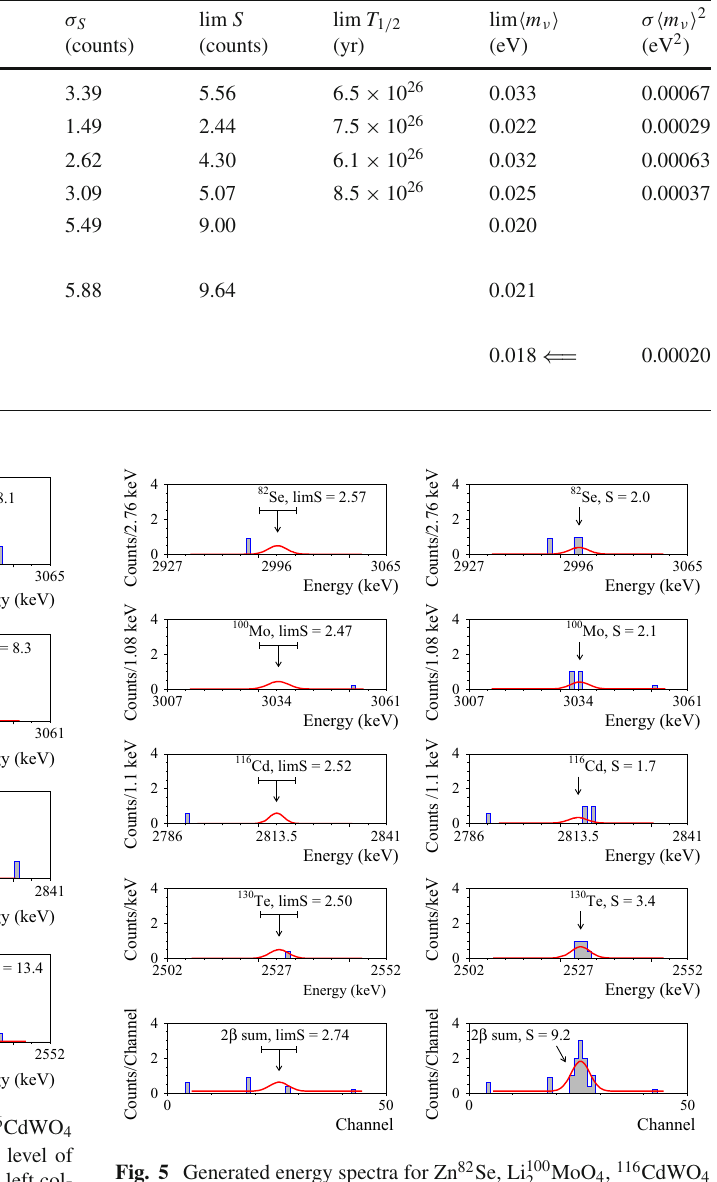
culated): the different versions of the quasiparticle random- phase approximation from the Tübingen (QRPA Tu) [50] and Jyväskylä (QRPA Jy) [51]; the microscopic